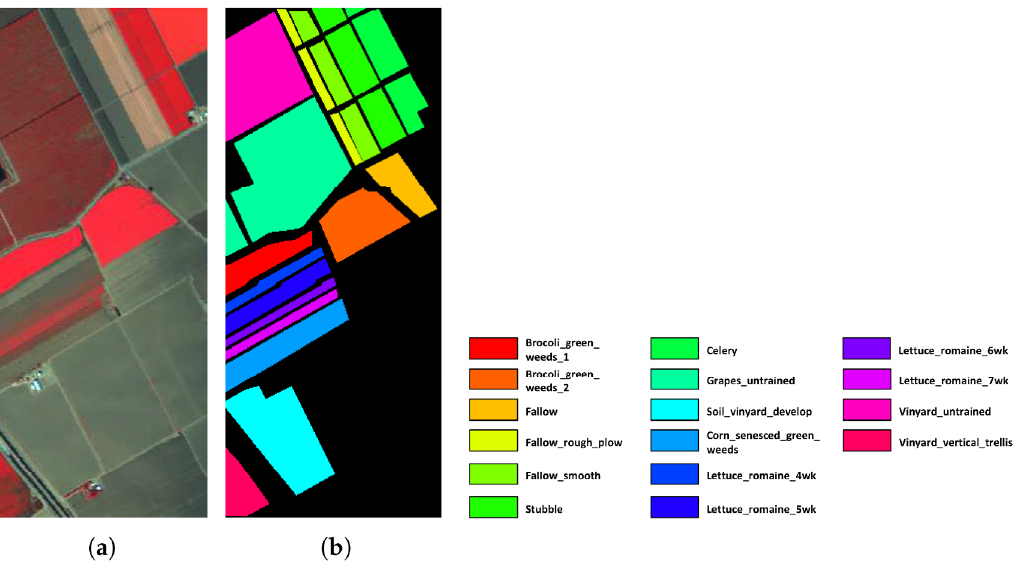
Figure 4. Images taken from Salinas Dataset: ( a ) Segmented Image; ( b ) Ground truth labelled